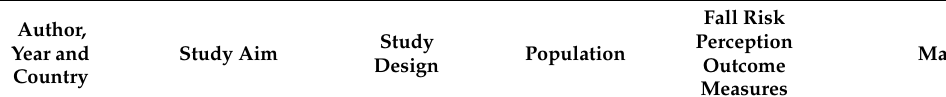
Table A1. Data summary